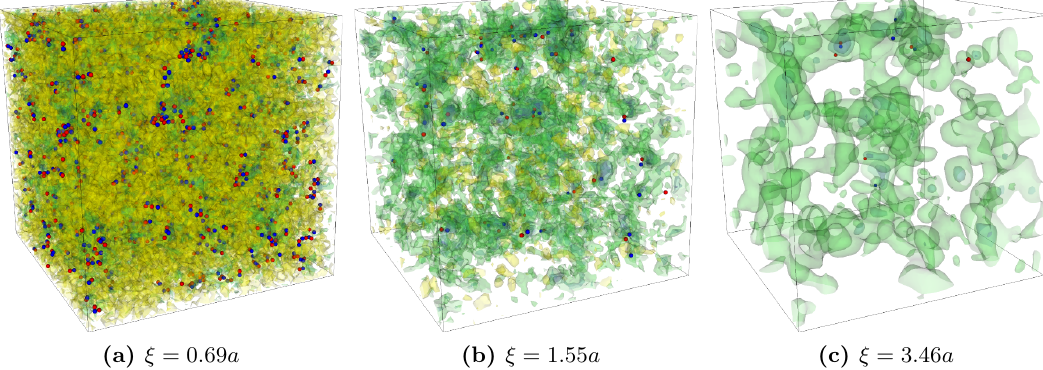
Figure 1 . Gradient flow applied to a hot configuration containing ’t Hooft-Polyakov monopoles and antimonopoles (blue and red dots, respectively). Isosurfaces of Tr φ 2 are shown in shades of green, and ξ labels the smoothing radius as described in the text. Monopoles appear where the Higgs field approaches zero (bluer regions). Monopole-antimonopole pairs produced by short-distance fluctuations annihilate as the flow proceeds, and only widely separated monopoles remain at long flow times. The simulation is for x = 0 . 35 , y = 0 . 03 , β = 8 on a 64 3 lattice. Full movie is available at